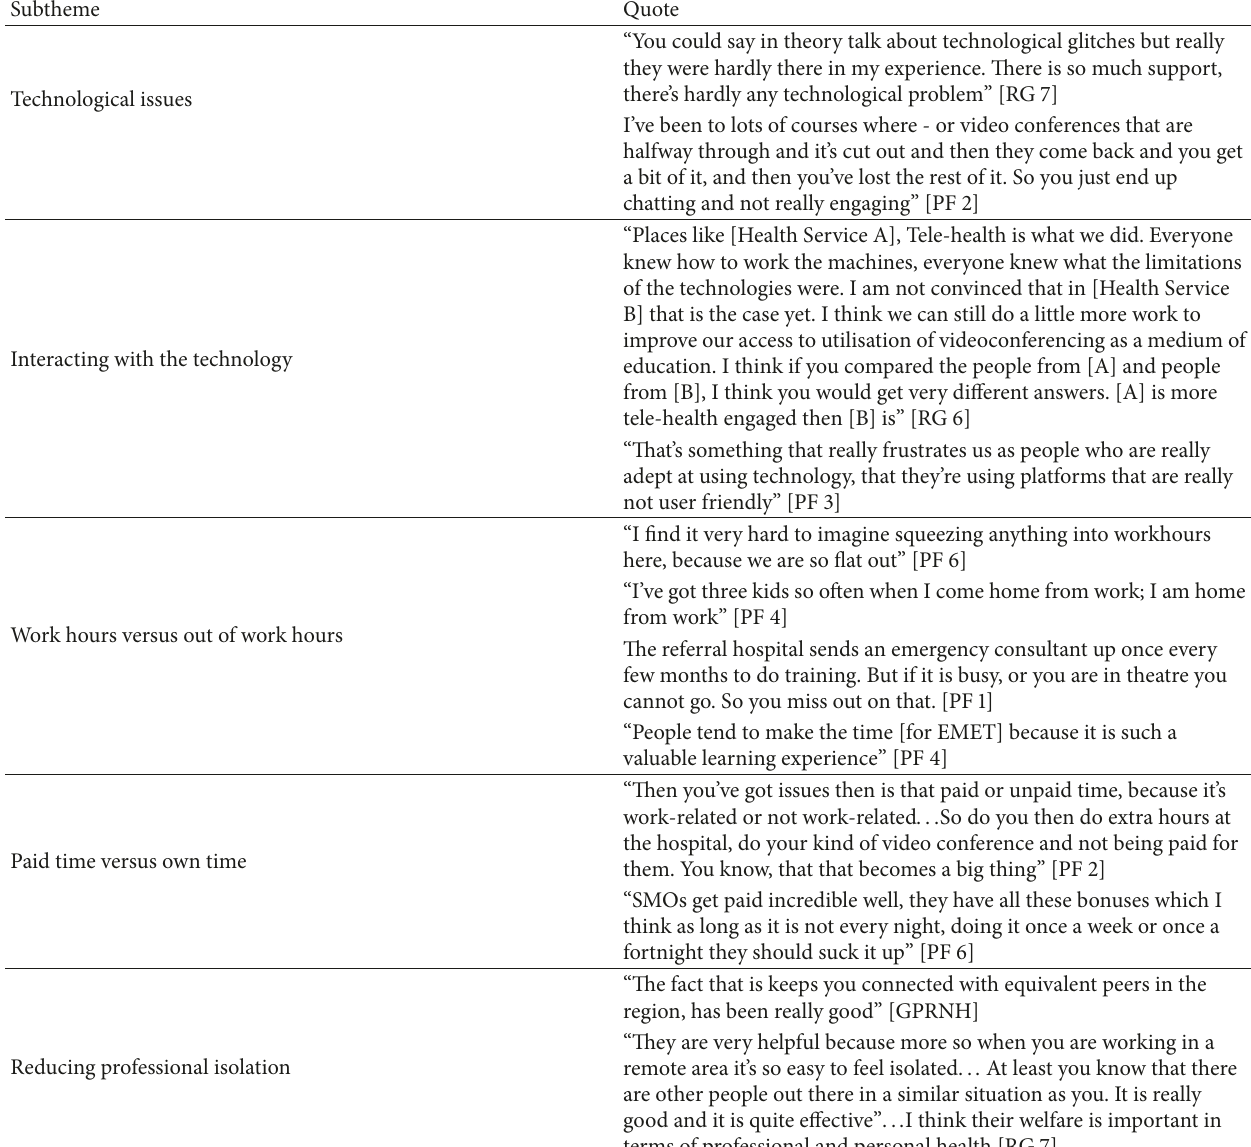
Table 3: Personal